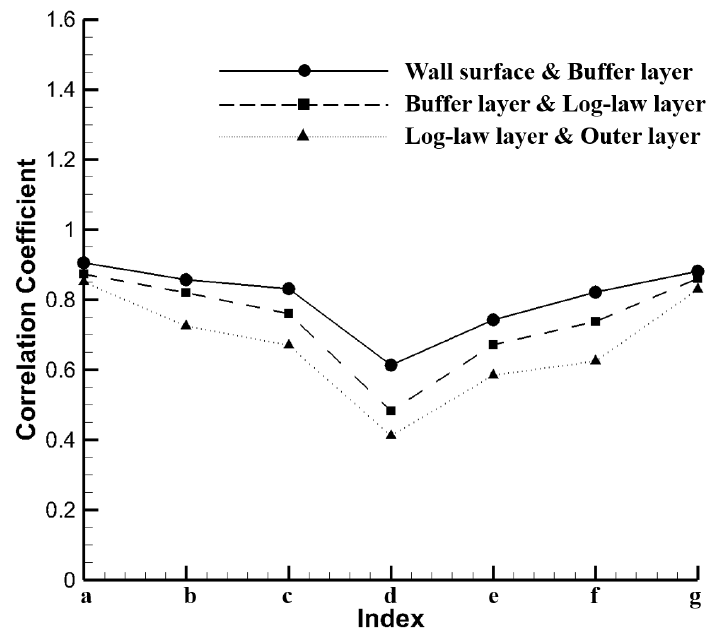
Figure 12. The distribution of the correlation coefficient between different layers near the limiting